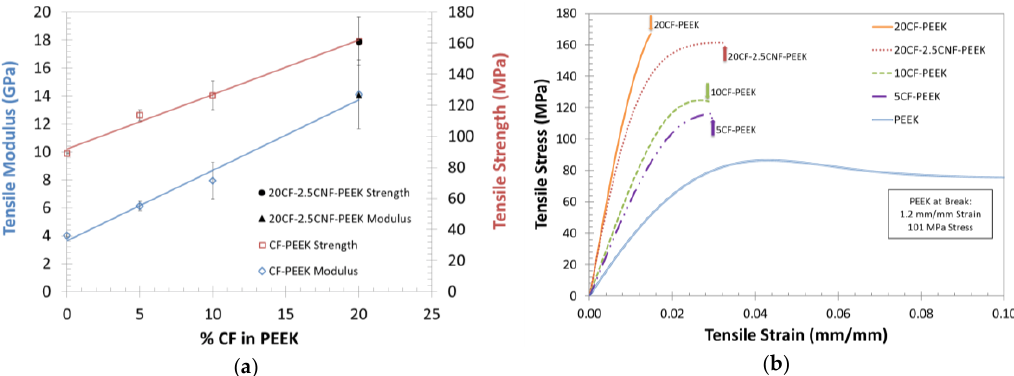
Figure 5. Average tensile modulus and strength for varying wt. % CF in PEEK and the 20CF–2.5CNF- PEEK ( a ); and the corresponding representative stress–strain curve for those samples ( b ).